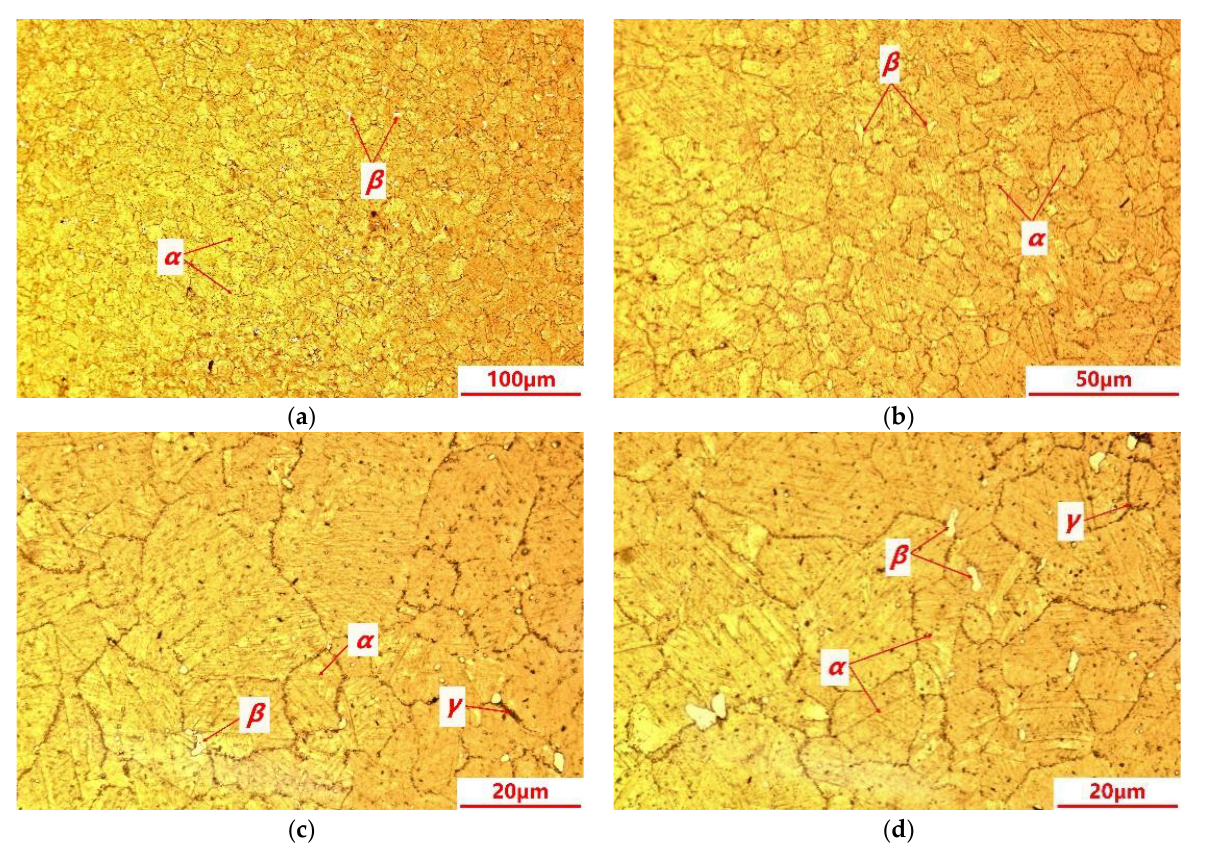
Figure 6. Microstructures of C17200 beryllium copper alloy. ( a ) Microstructure with magnification of 200×; ( b ) microstructure with magnification of 500×; ( c ) microstructure with magnification of 200 × ; ( b ) microstructure with magnification of 500 × ; ( c ) microstructure with magnification of 1000 × ; 1000×; and ( d ) microstructure with magnification of 1000×. and ( d ) microstructure with magnification of 1000 ×